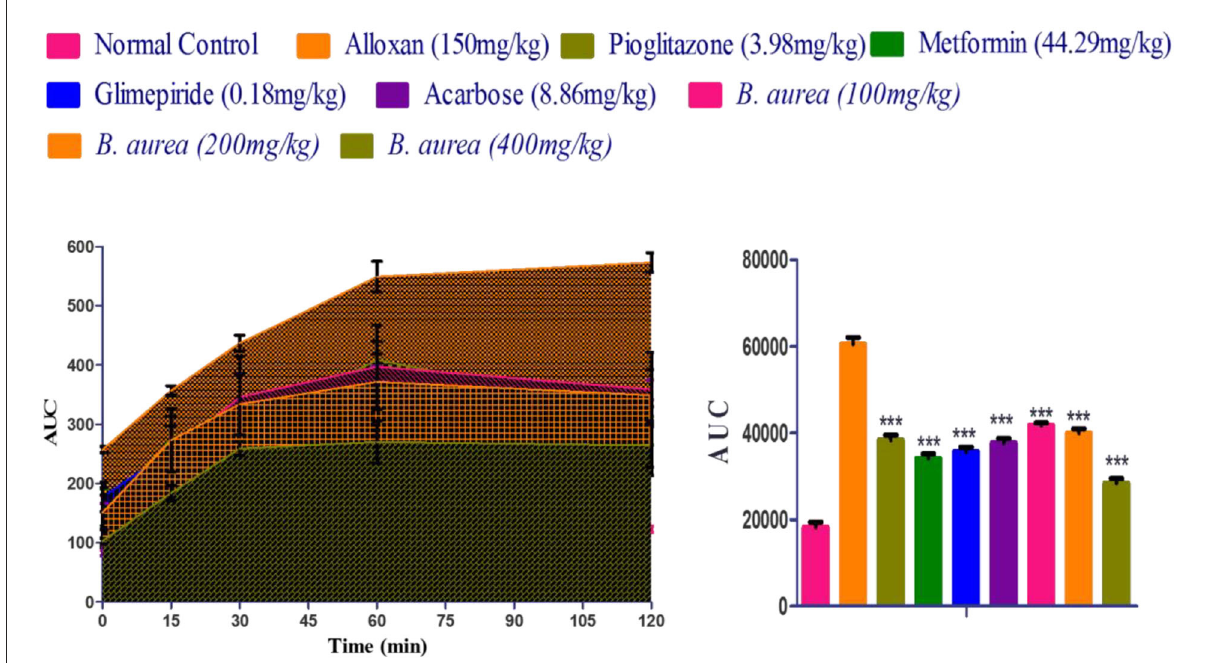
FIGURE3 Measurement of the area under the curve (AUC) of the treated groups that depicted the findings of the oral glucose tolerance test. *** p < 0.001, ** p < 0.01, * p < 0.05 significant values were obtained after analysis by one-way